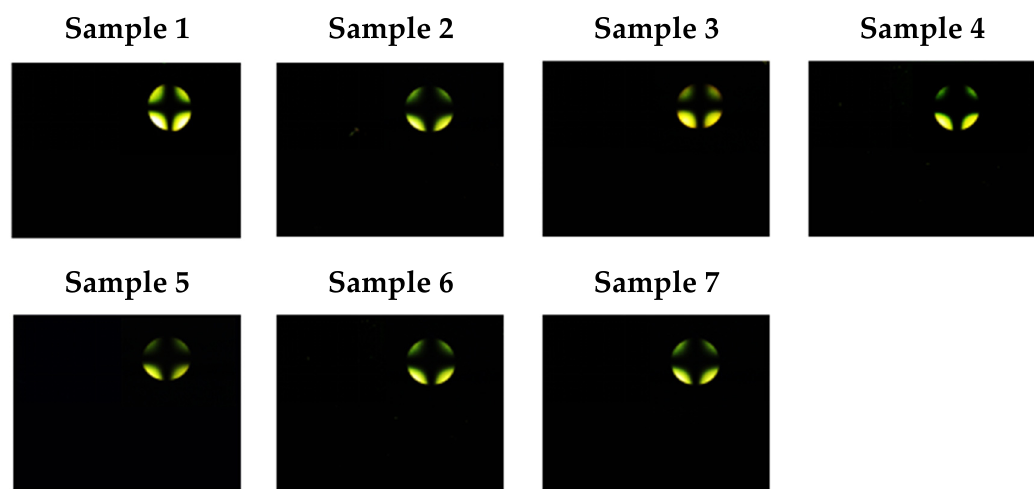
Figure 6. POM of the M1-doped 5CB mixtures with different mass fractions (insets are the conoscopic POM of the mixtures).